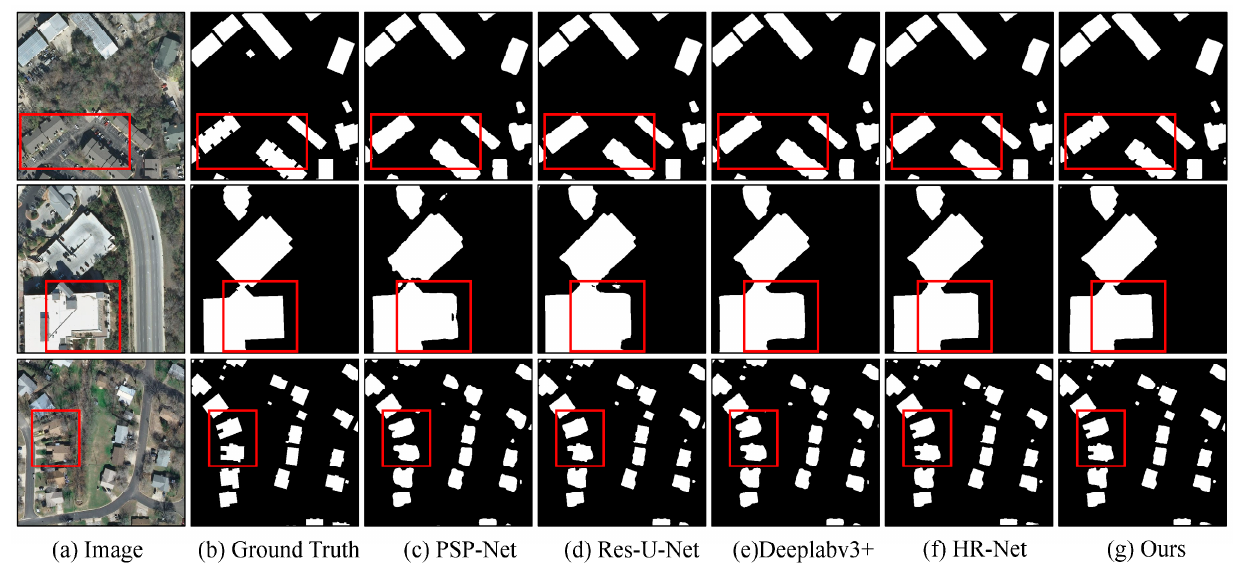
Figure 9. Examples of MEC-Net using the Inria dataset.